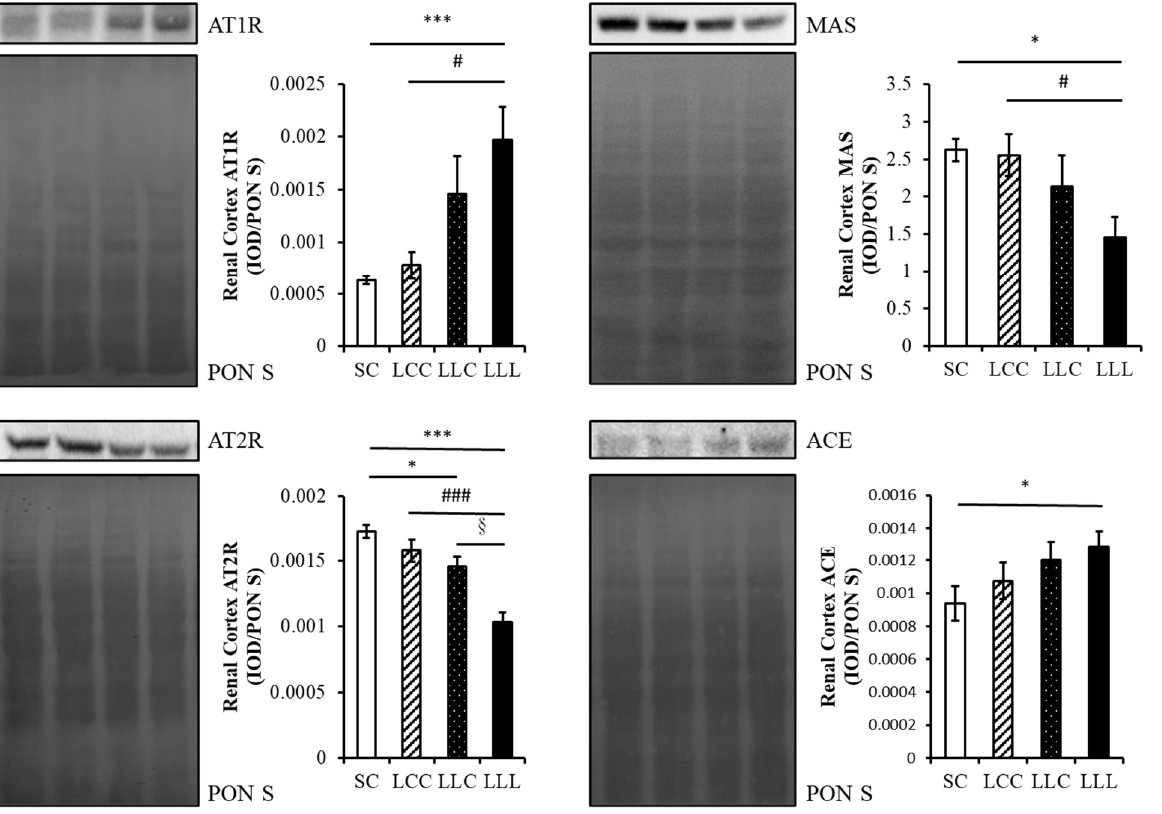
Figure 4. Offspring renal cortex AT1R, AT2R, MAS, and ACE abundance. Four groups were evaluated by one-way ANOVA with the LSD post hoc test. * vs. SC, p < 0.05; *** vs. SC, p < 0.001; # vs. LCC, p < 0.05; ### vs. LCC, p < 0.001; § vs. LLC, p < 0.05.